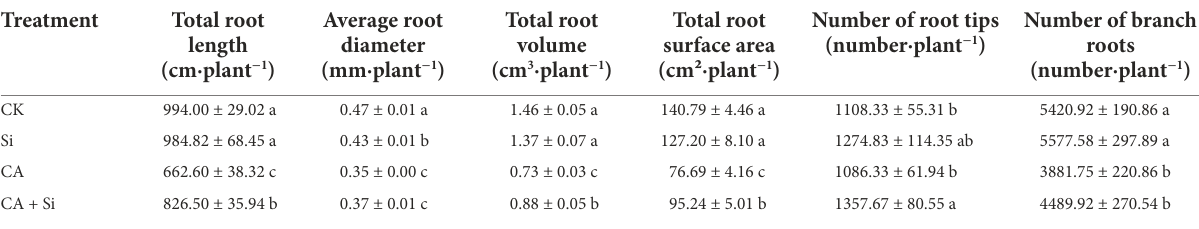
TABLE 1 Effect of exogenous Si on total root length, average root diameter, total root volume, total root surface area, number of root tip, and number of branch roots in cucumber seedlings under cinnamic acid (CA)-induced autotoxicity stress.